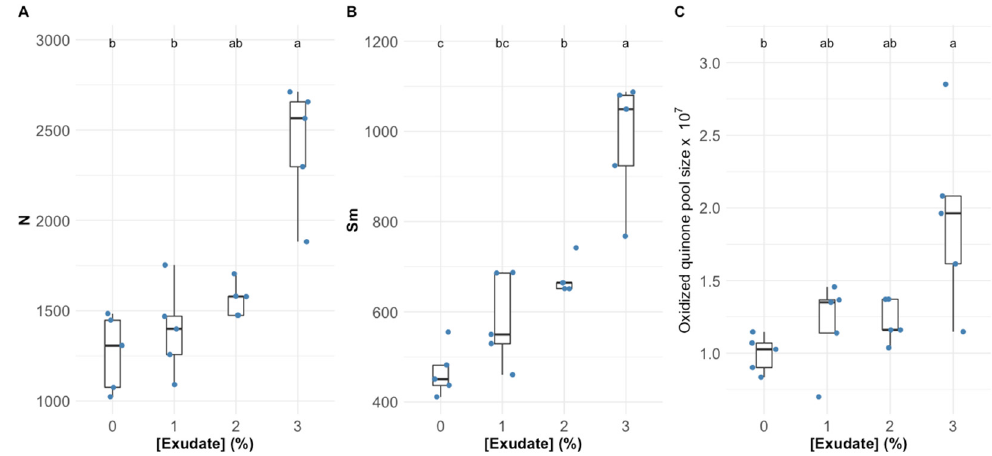
Figure 2. Thellungiella halophila dark-adapted leaves’ reaction centres turnover rate, N ( A ), the energy needed to close all the reaction centres, Sm ( B ), and the oxidized quinone pool size ( C ) exposed to Asparagopsis armata exudate at the proposed target concentrations at the end of the trial period (N = 5 per treatment; letters denote significant differences between treatments at p < 0.05).